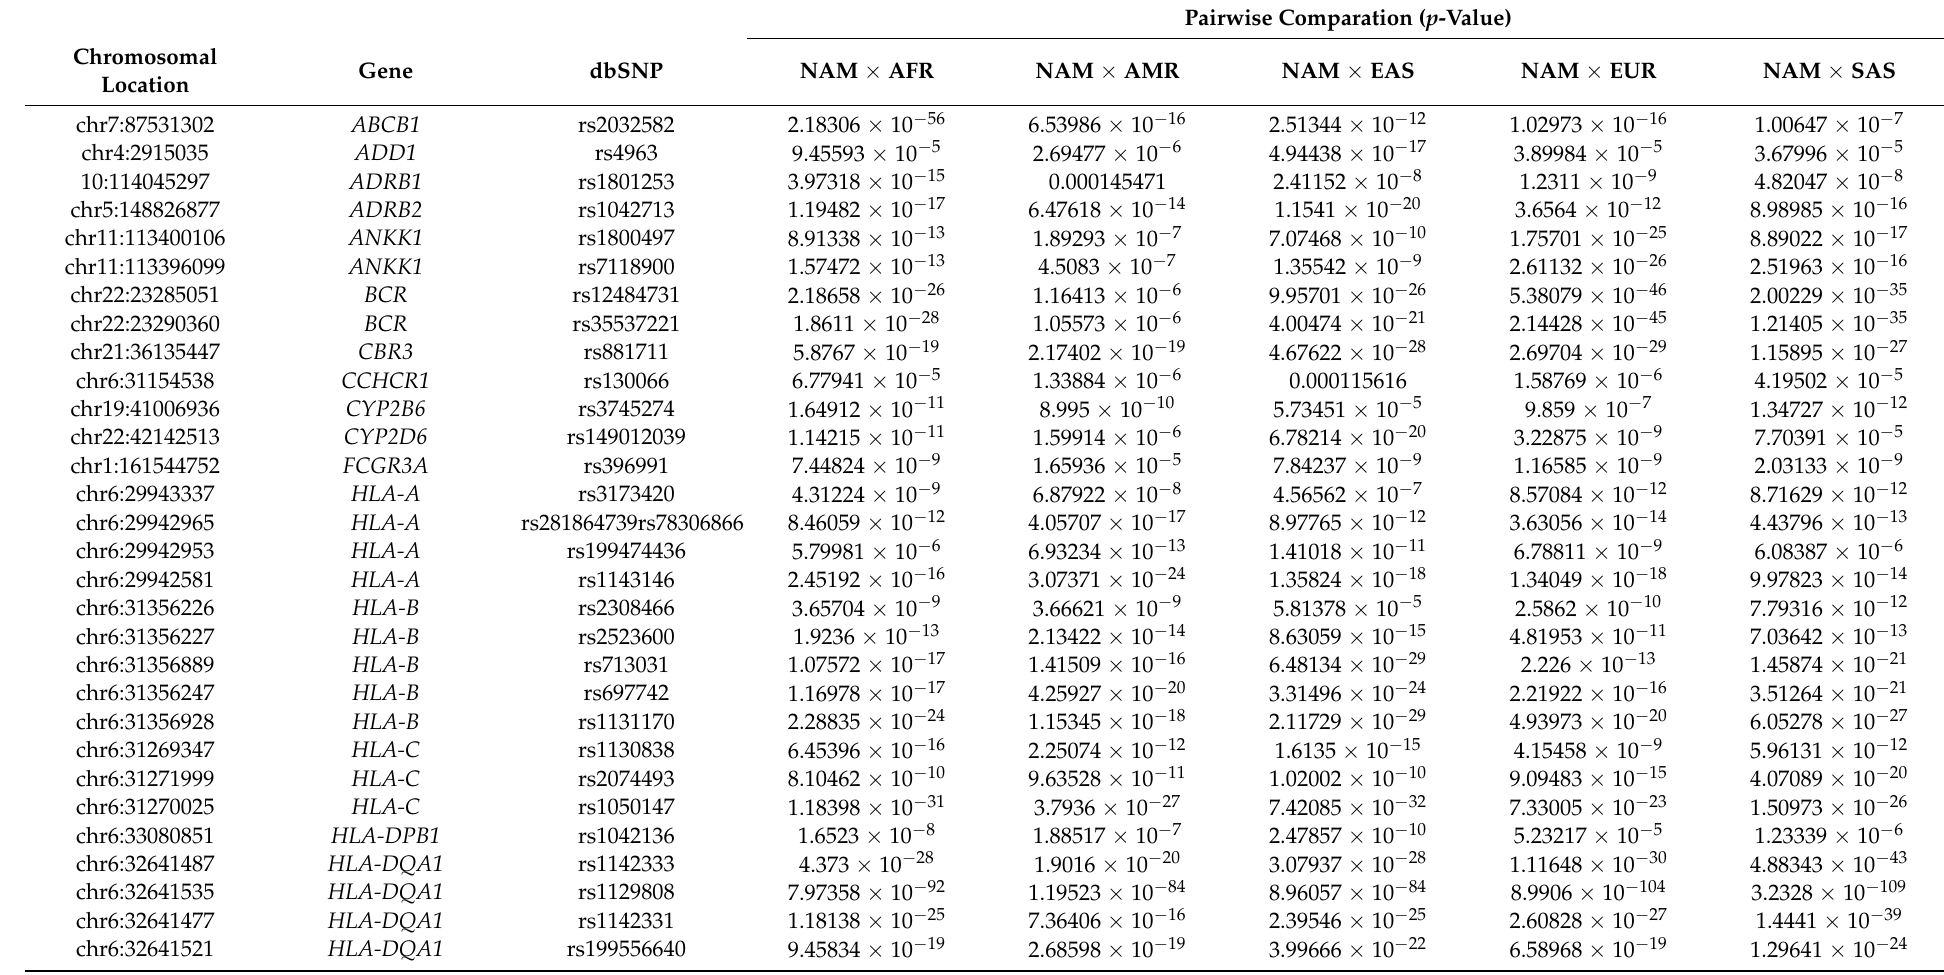
Table 3. Pairwise comparison of variants with a statistically significant difference of allele frequency between Amazonian Amerindians and all continental populations from the ExAC